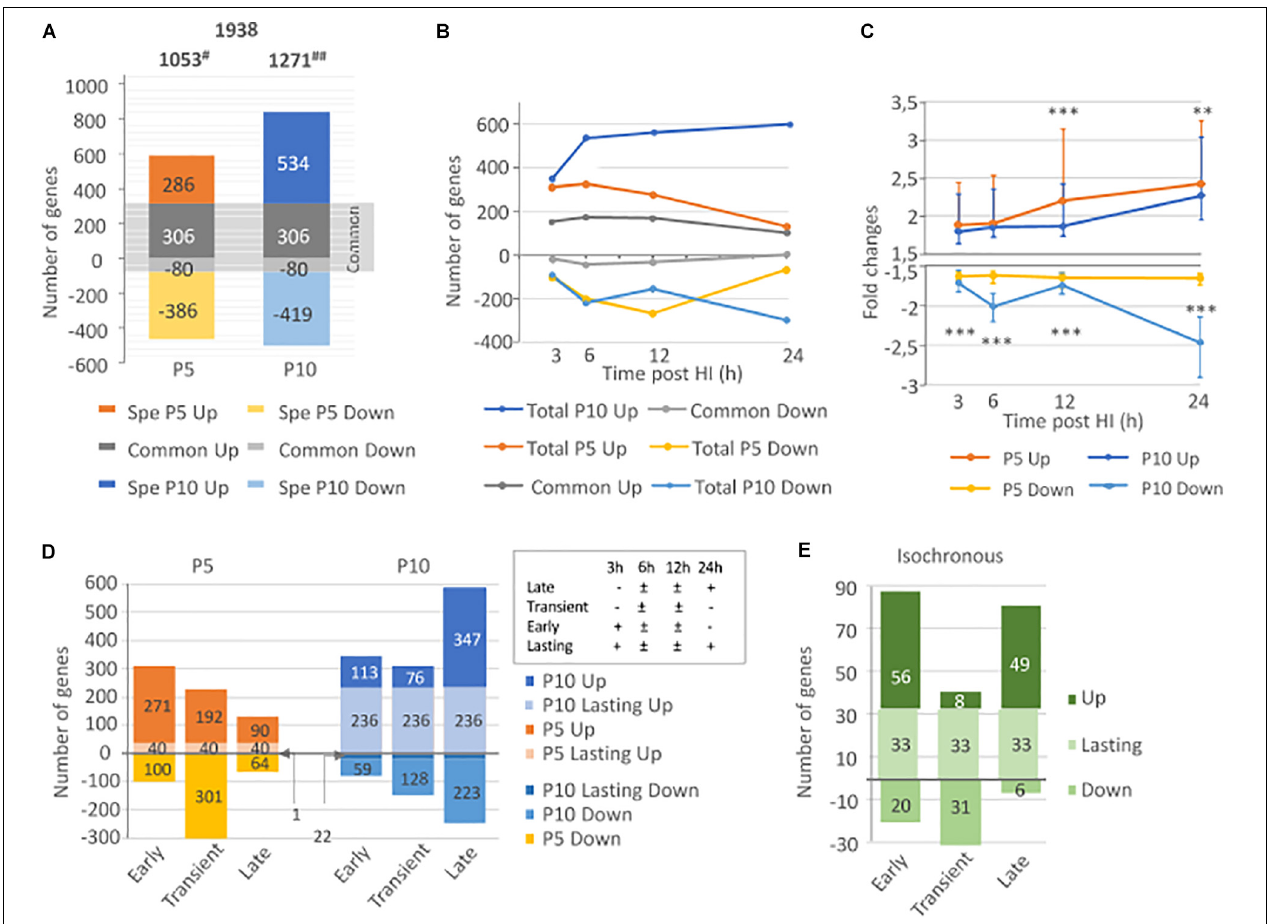
FIGURE 2 | Comparison of HI effects on transcription in the neonate’s brain at P5 and P10. (A) Total number of inductions and repressions (noted as negative values) at P5, P10, and in common to both ages, (B) Time course of induction/repression numbers in P5, P10, and in common, along the 24 h period following HI (C) Comparison of median induction and repression amplitudes ( ± interquartile) along the 24 h after HI in P5 and P10 brains. (D) Distribution of total P5 or P10 inductions and repressions, classified as early, transient, late, or lasting kinetics (details in inset) (E) Kinetics distribution of genes exhibiting isochronous responses (based on the 4 classes) at both ages. # Includes 5 biphasic effects (induction and repression of single genes) in P5, and ## 68 biphasic regulations in P10 brains. ** p < 0.01; *** p < 0.0001 according to Mann and Whitney